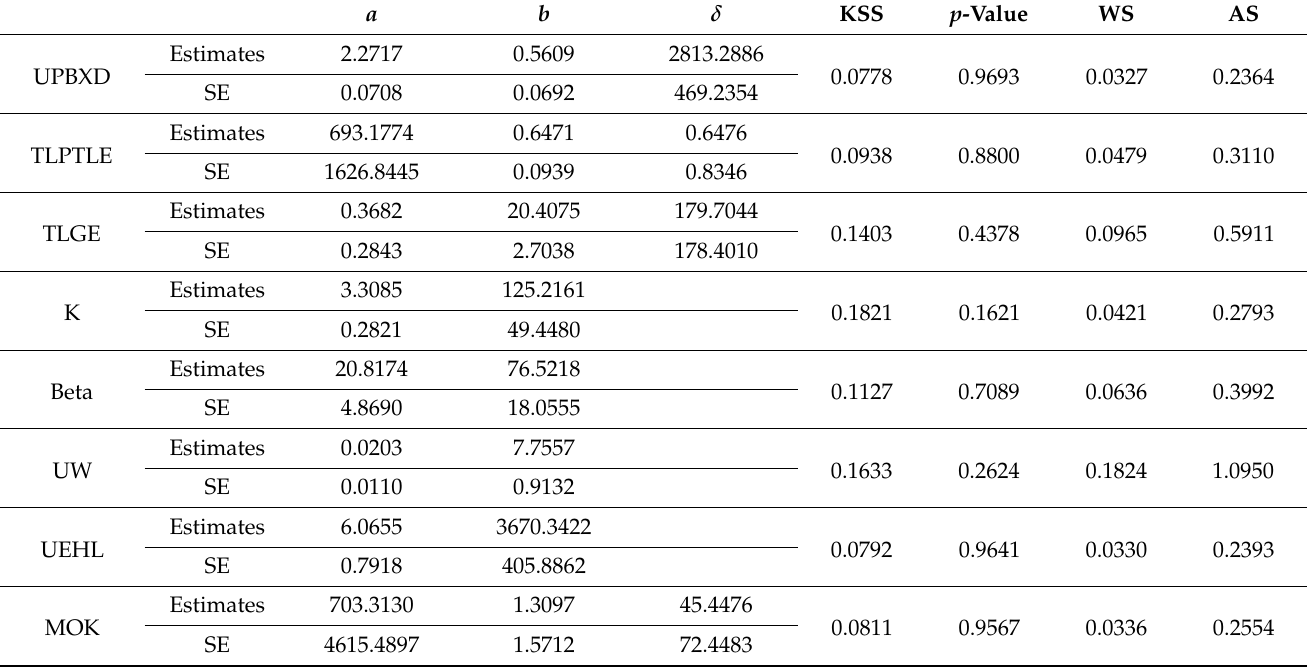
Table 7. ML estimates with SE and goodness of fit statistics: Saudi Arabia data set. a b δ KSS p -Value WS